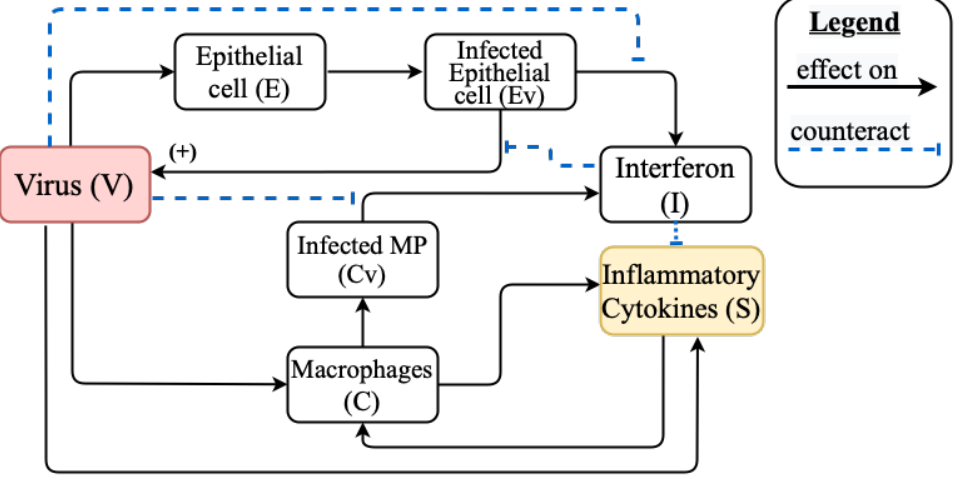
Figure A3. Representation of the mathematical model considered for the study of the emergency of the cytokine storm. The propose model is based on the model of the innate immune response by adding the corresponding member to describe the pro-inflammatory cytokines.